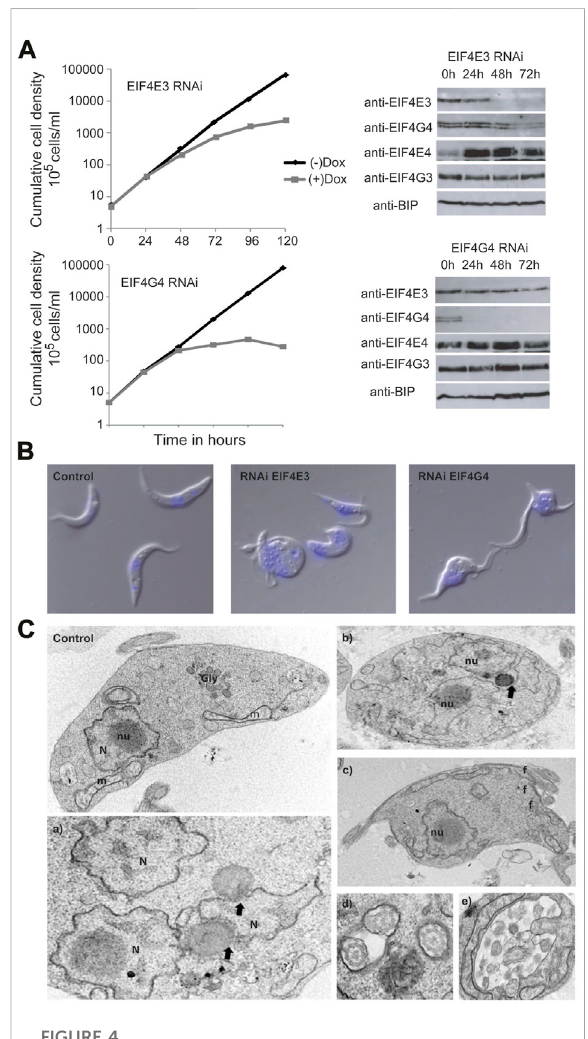
FIGURE 4 Analysis of the EIF4G4 depletion effects in cell morphology (A) Representative growth curves of T. brucei procyclic cells submitted to the EIF4E3 and EIF4G4 RNAi after 24, 48, and 72 h Doxycycline induction (+Dox) and without RNAi induction (-Dox). Western blots using the polyclonal antibodies anti-EIF4E3, anti-EIF4E4, anti-EIF4G4 and anti-EIF4G3 in the RNAi induced cell lines. Anti-BIP was used as a loading control. (B) Confocal microscopy of T. brucei procyclic cells with the EIF4E3 RNAi after 48 h of induction with Doxycycline. Cells with an aberrant phenotype consisting of multiple nuclei and fl agella can be observed in the RNAi samples. In blue, DNA stained with DAPI. (C) Electron microscopy of T. brucei procyclic cells after 48 h of EIF4G4 RNAi induction. Control — T. brucei procyclic cell without RNAiinduction,showingthepreservedorganelles:nucleus(N)and nucleolus (nu), glycosome (Gly) and mitochondrion (m). a) and b) Cells displaying multiple nuclei (N) and disintegration of the nucleolus. Black arrows pointing membrane bridges between nuclear envelope membrane and lipid-like inclusions. c) Cell exhibiting multiple fl agella (f). d) Multiple fl agella in the same fl agellar pocket. e) Atypical exocytic activity in the fl agellar